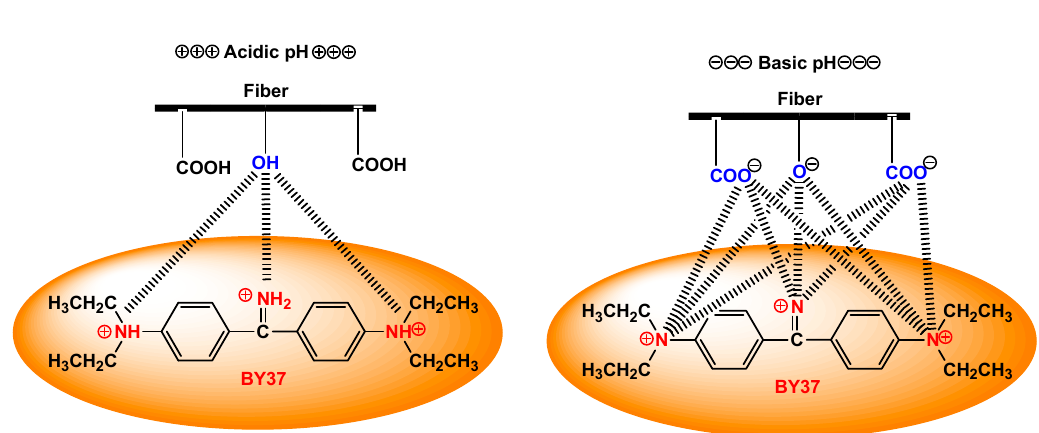
Figure Figure 5. Proposed adsorption mechanism between the fiber with BY37 at acidic and basic pH conditions.